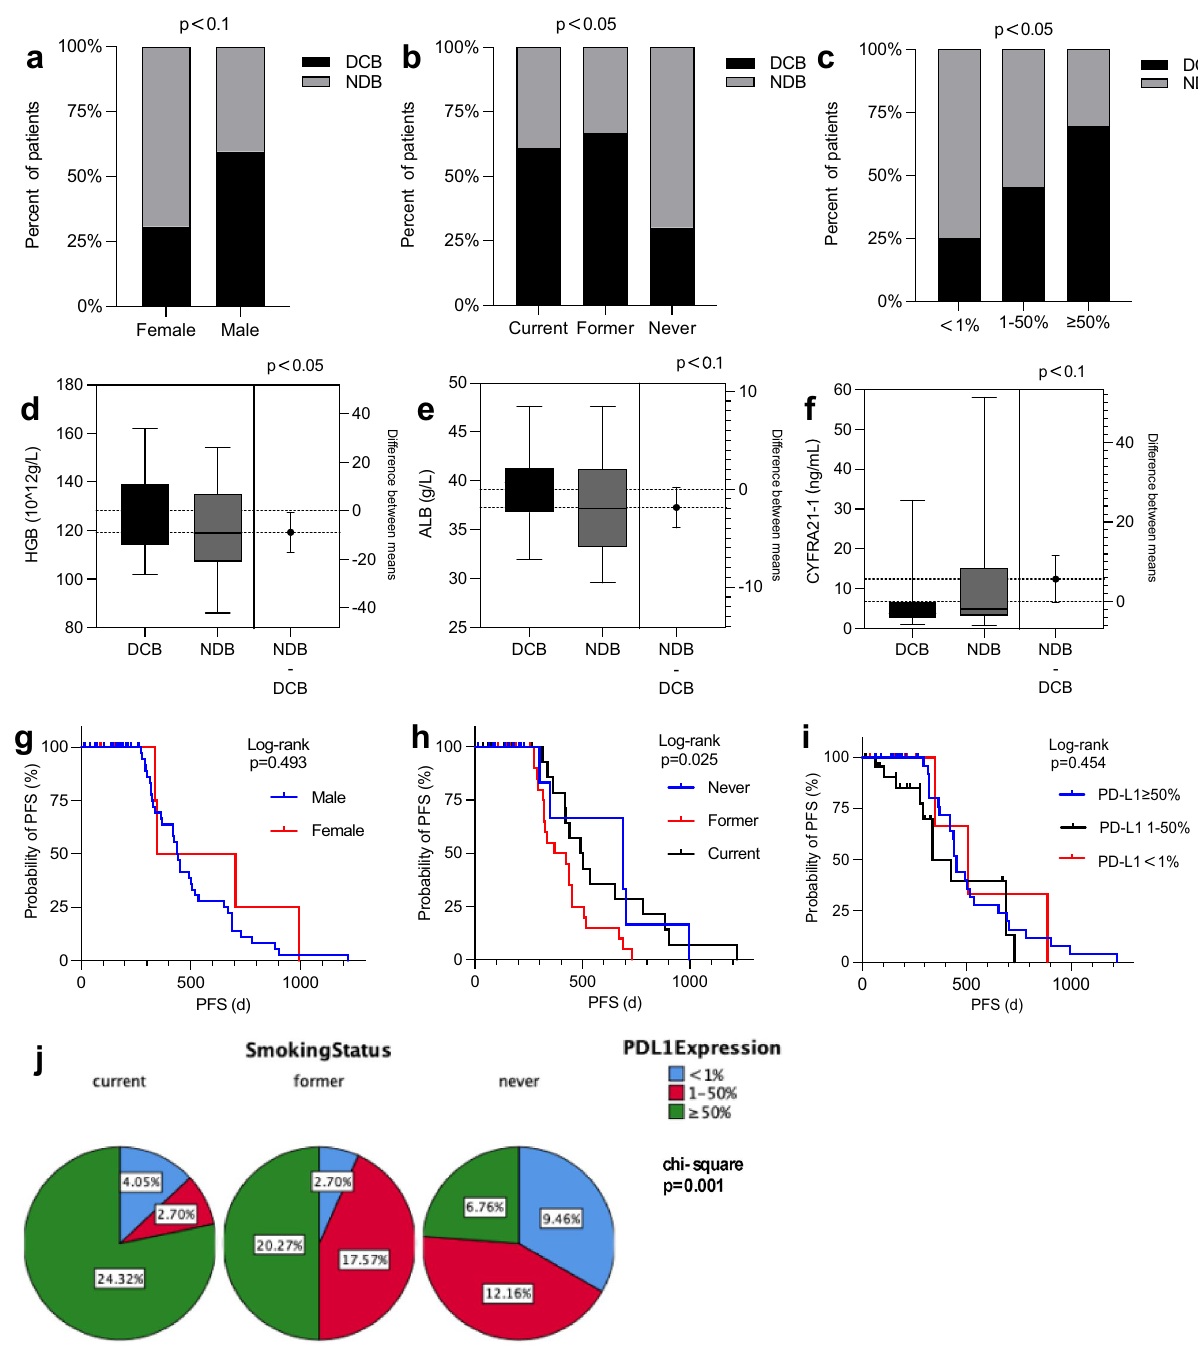
Figure 1. Pre-treatment clinical characteristics predict response to ICI plus chemotherapy. ( a – c ) Outcomes of patients stratified by Sex, Smoking status and PD-L1 expressing. p value was calculated by Univariate Logistic Regression Analysis (DCB n = 40; NDB n = 34). ( d – f ) Pre-treatment HGB, ALB and CYFRA21-1 in patients. p values were calculated using Univariate Logistic Regression Analysis. ( g ) Probability of PFS for male (median = 437 day) and female (median = 347 day). ( h ) Probability of PFS for current smokers (median = 689 day), former smokers (median = 336 day) and never smokers (median = 491 day). ( i ) Probability of PFS for PD-L1 expression < 1% (median = 507 day), PD-L1 expression ranged from 1 to 50% (median = 328 day) and PD-L1 expression ≥ 1% (median = 437 day). ( j ) Degree of smoking positively correlated with PD-L1 expression (p <